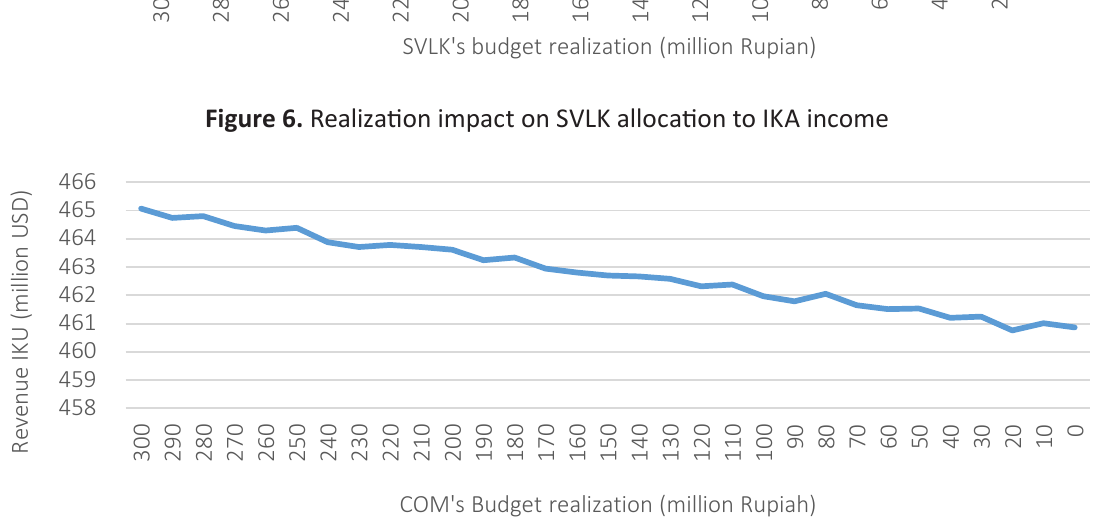
Figure 7. Realization impact on COM allocation to IKU